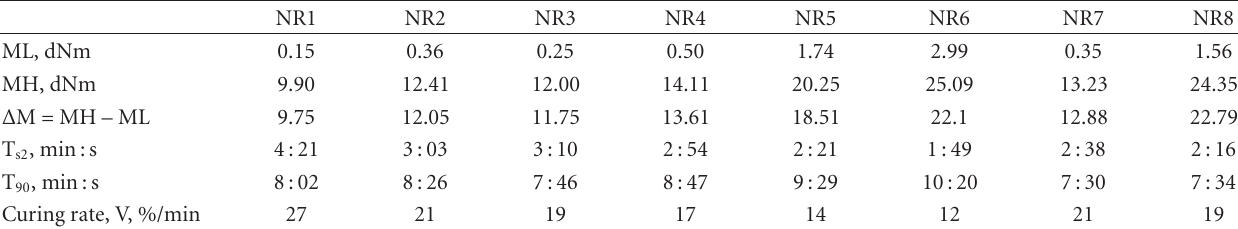
Table 3: Curing properties of the investigated rubber compounds at 150 ◦